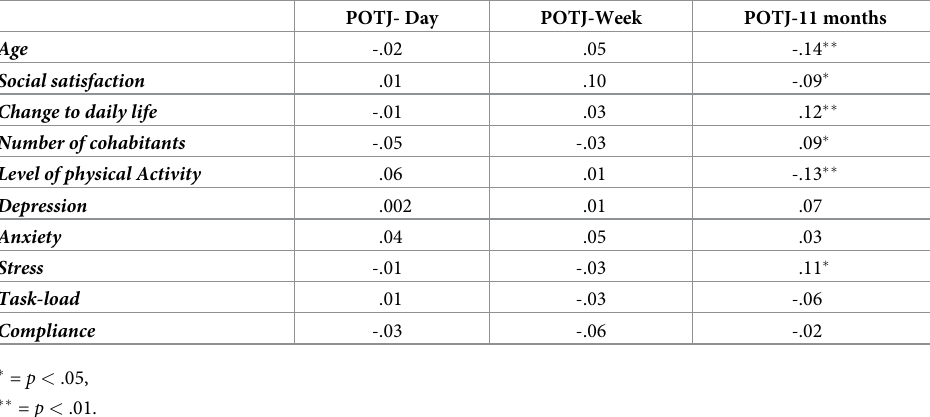
Table 3. Correlation coefficients between POTJs, age, measures of affect, load, compliance, number of cohabi- tants and change to